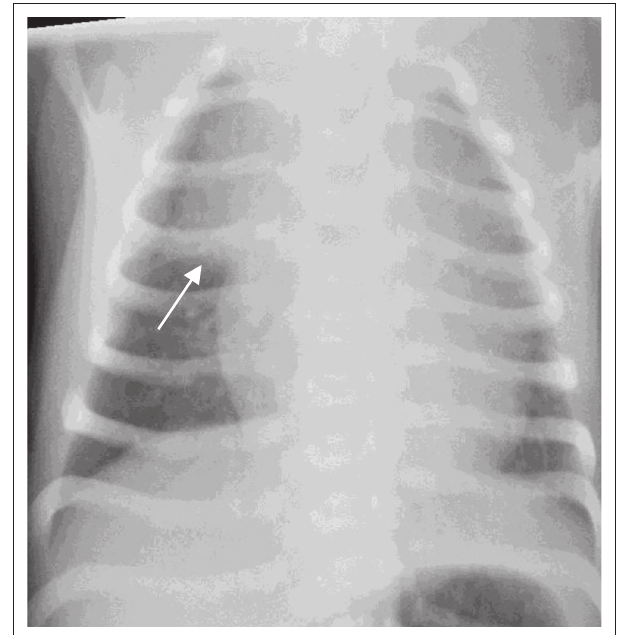
FIGURE 6: Frontal chest radiograph. A classic sail sign (arrow) formed by the right lobe of the thymus flattened at the minor